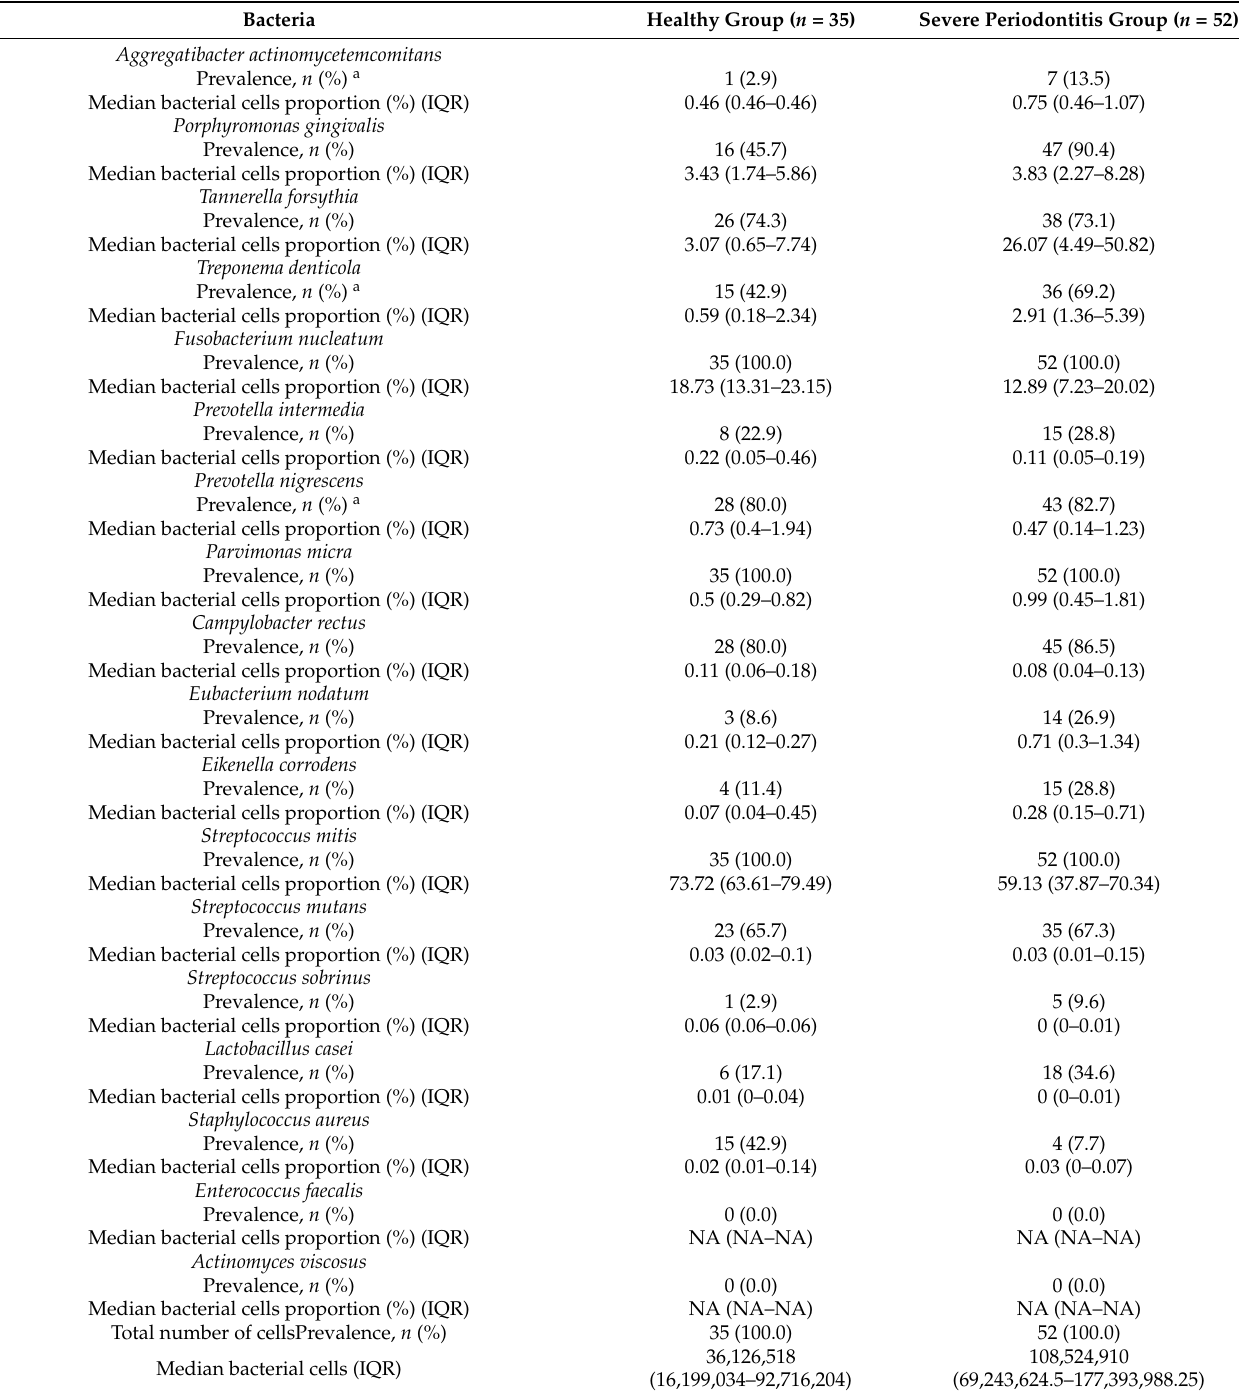
Table 3. Prevalence of target species and their quantities in polymerase chain reaction-positive